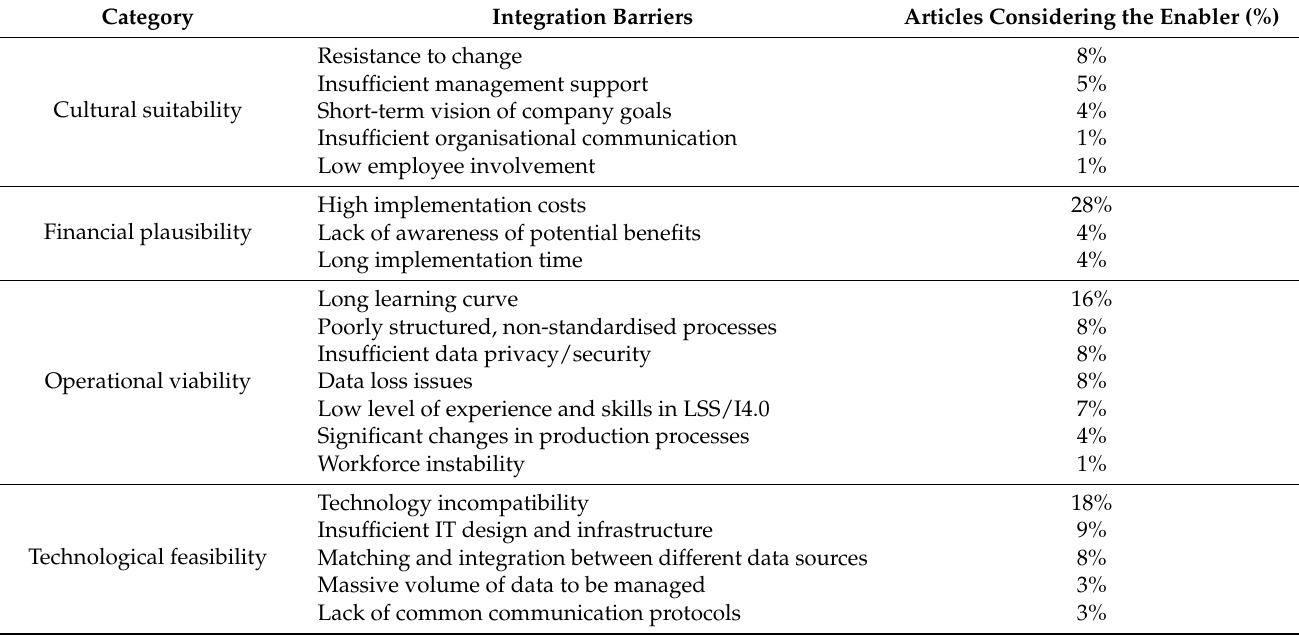
Table 5. I4.0 and LSS integration